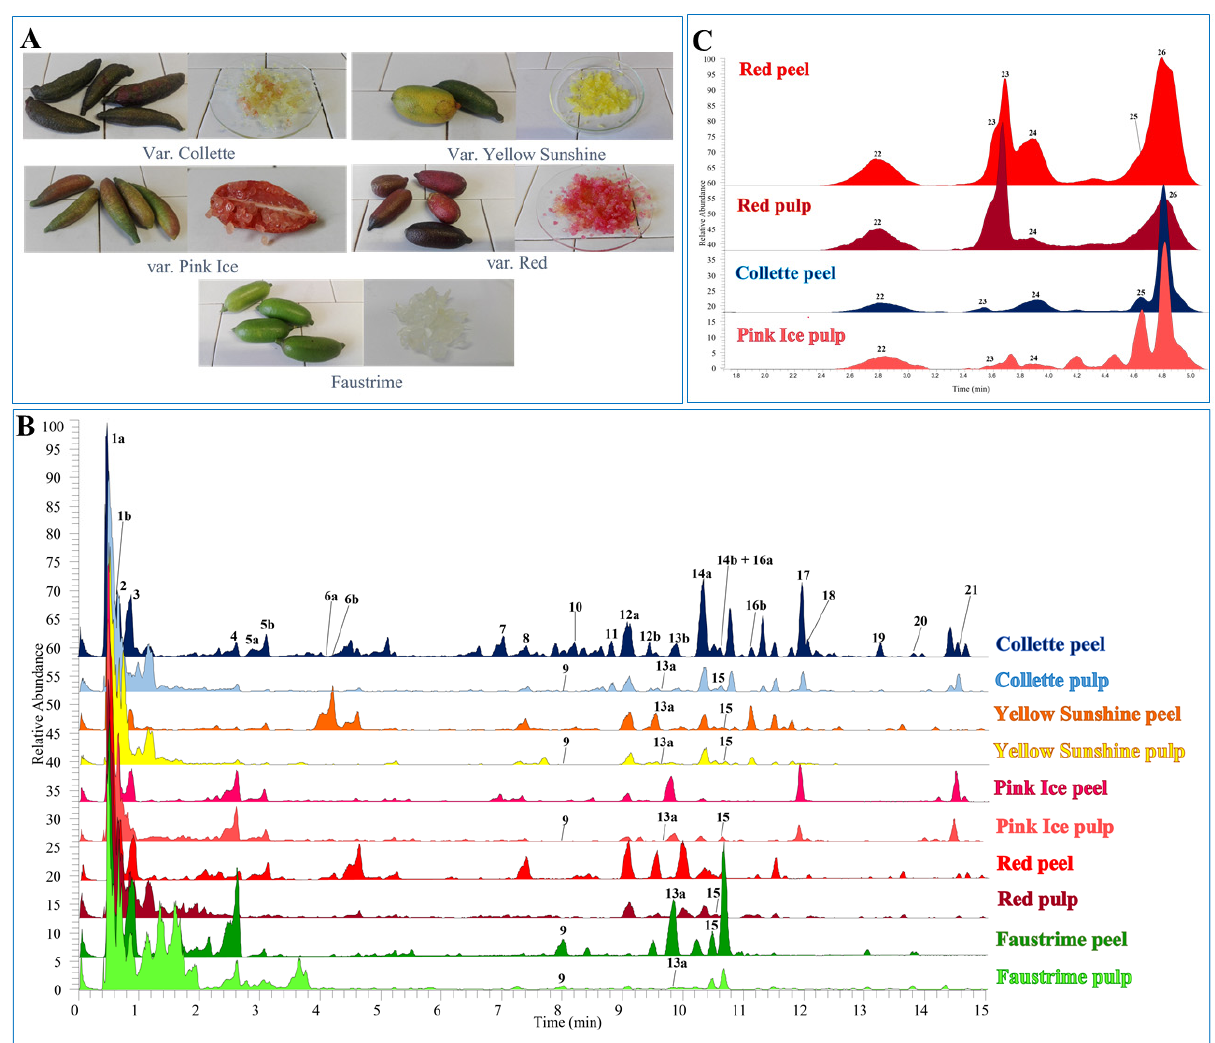
Figure 1. ( A ) Citrus australasica studied varieties; ( B ) comparison of chromatograms of C. australasica peels and pulps extracts, recorded by UHPLC-HR-Orbitrap/ESI-MS analyses in negative ion mode; ( C ) anthocyanin HR-Orbitrap/ESI-MS profiles of C. australasica peels and pulps, recorded in positive ion mode.